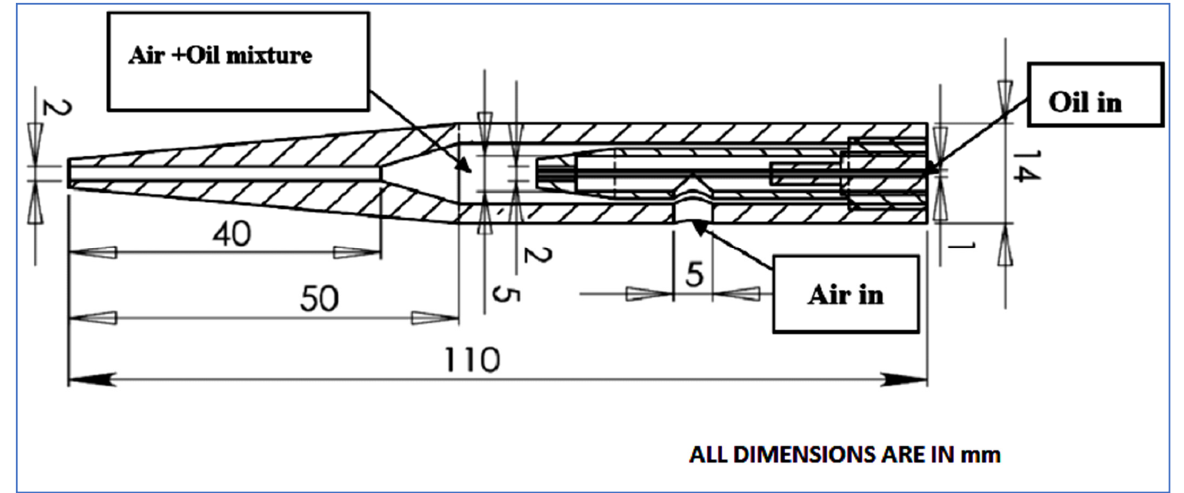
Figure 3. Details of MQL setup.